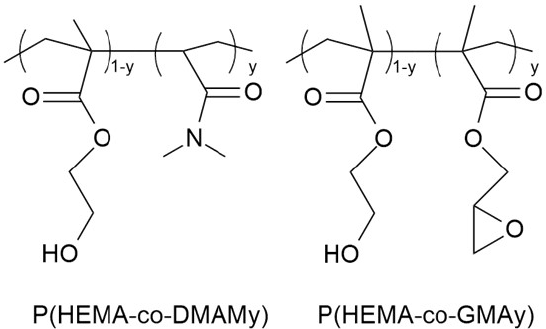
Figure 1. Chemical structures of P(HEMA-co-DMAMy) and P(HEMA-co-GMAy). 1 H NMR was employed for the characterization of the P(HEMA-co-DMAMy) copol- ymers (Figure 2a). The 1 H NMR study of the P(HEMA-co-DMAMy) copolymers and the homopolymers PHEMA and PDMAM was performed in d 4 -MeOH. The peaks within the range 0.80–1.20 ppm are attributed to the methyl protons (a) of HEMA. The protons of the backbone (-CH 2 -, b, b ′ ; -CH, a ′ ) of HEMA and DMAM are identified in the range 1.20–2.20 ppm. The peaks observed at ~3.70 and ~4.20 ppm are attributed to the methylene protons d and c of HEMA, respectively. The presence of DMAM moieties in the final copolymers was confirmed by the existence of the signals in the range ~2.80–3.20 ppm, which corre- spond to the methyl protons (f, f’) connected with the nitrogen atom in the DMAM units. The integrals of the signals at 3.70 ppm (d protons of HEMA units) and at 2.80–3.20 ppm (f,f ′ protons of DMAM units) were used to calculate the molar ratio of HEMA and DMAM in the P(HEMA-co-DMAMy) copolymers. The results are summarized in Table 1. The cal- culated compositions of the copolymers are in good agreement with the feed composition of the reaction mixtures.